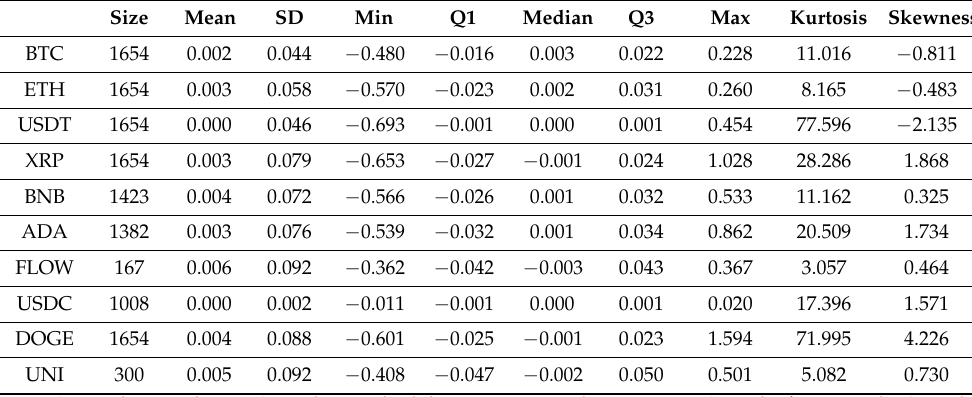
Table 1. Summary statistics of the top 10